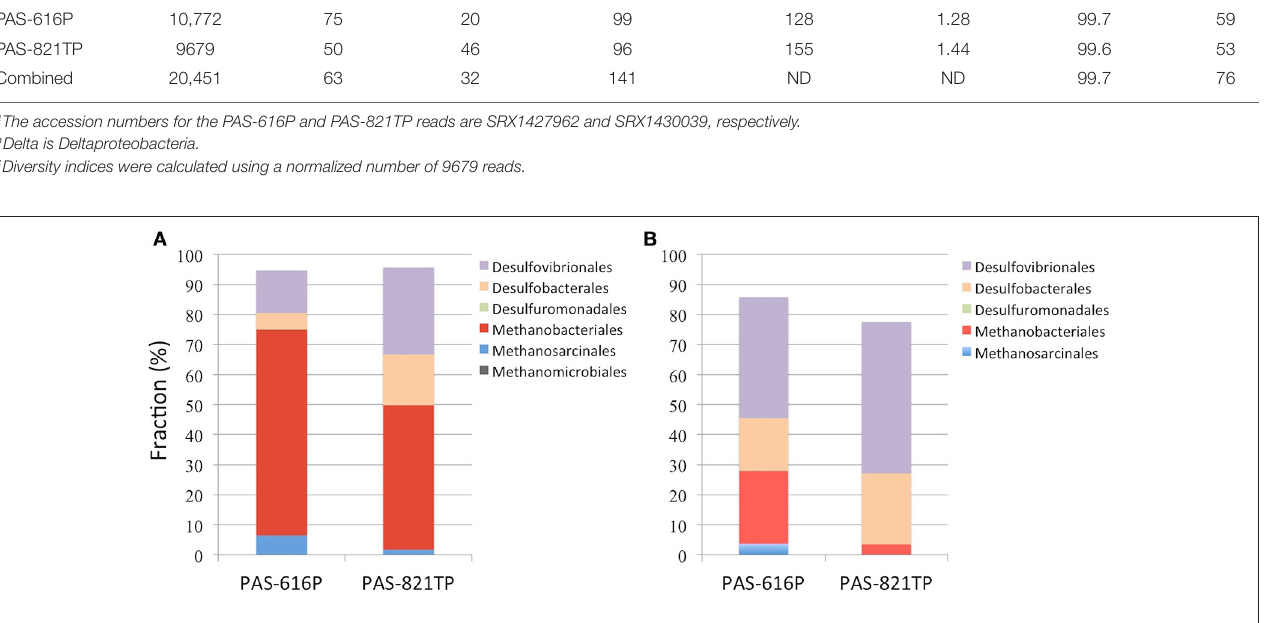
TABLE 2 | Summary of 454 metagenomic data obtained for CsCl purified DNAs from the PAS samples. Parameter